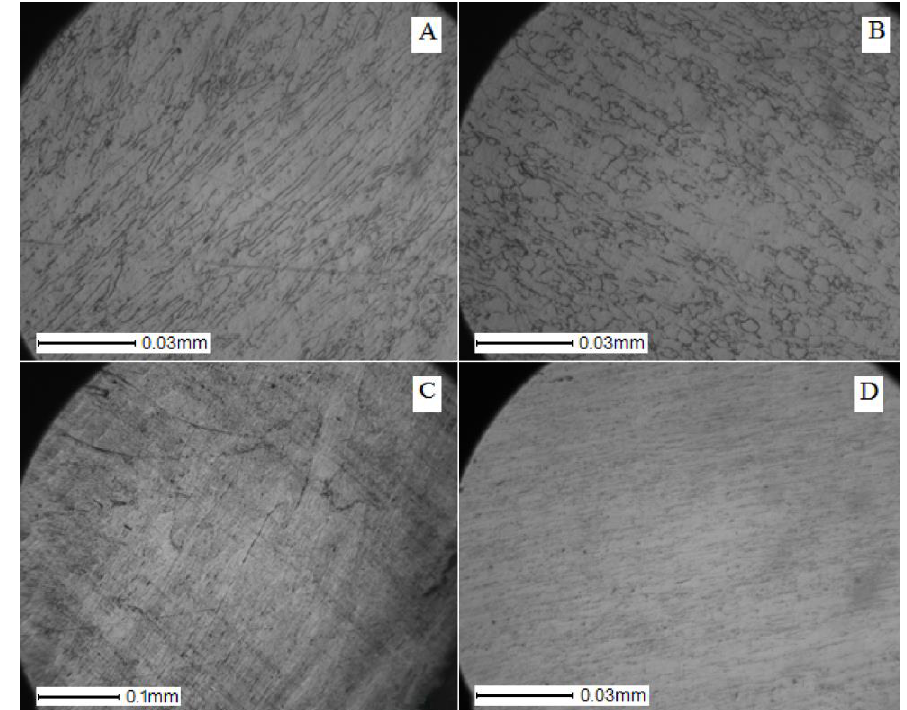
Figure 5. Photos of the microstructure of bars of the Ti–28Nb–5Zr alloy with ( A ) 8, ( B ) 4, ( C ) 2.5, and ( D ) 1.5 mm diameters in the longitudinal direction of the section.